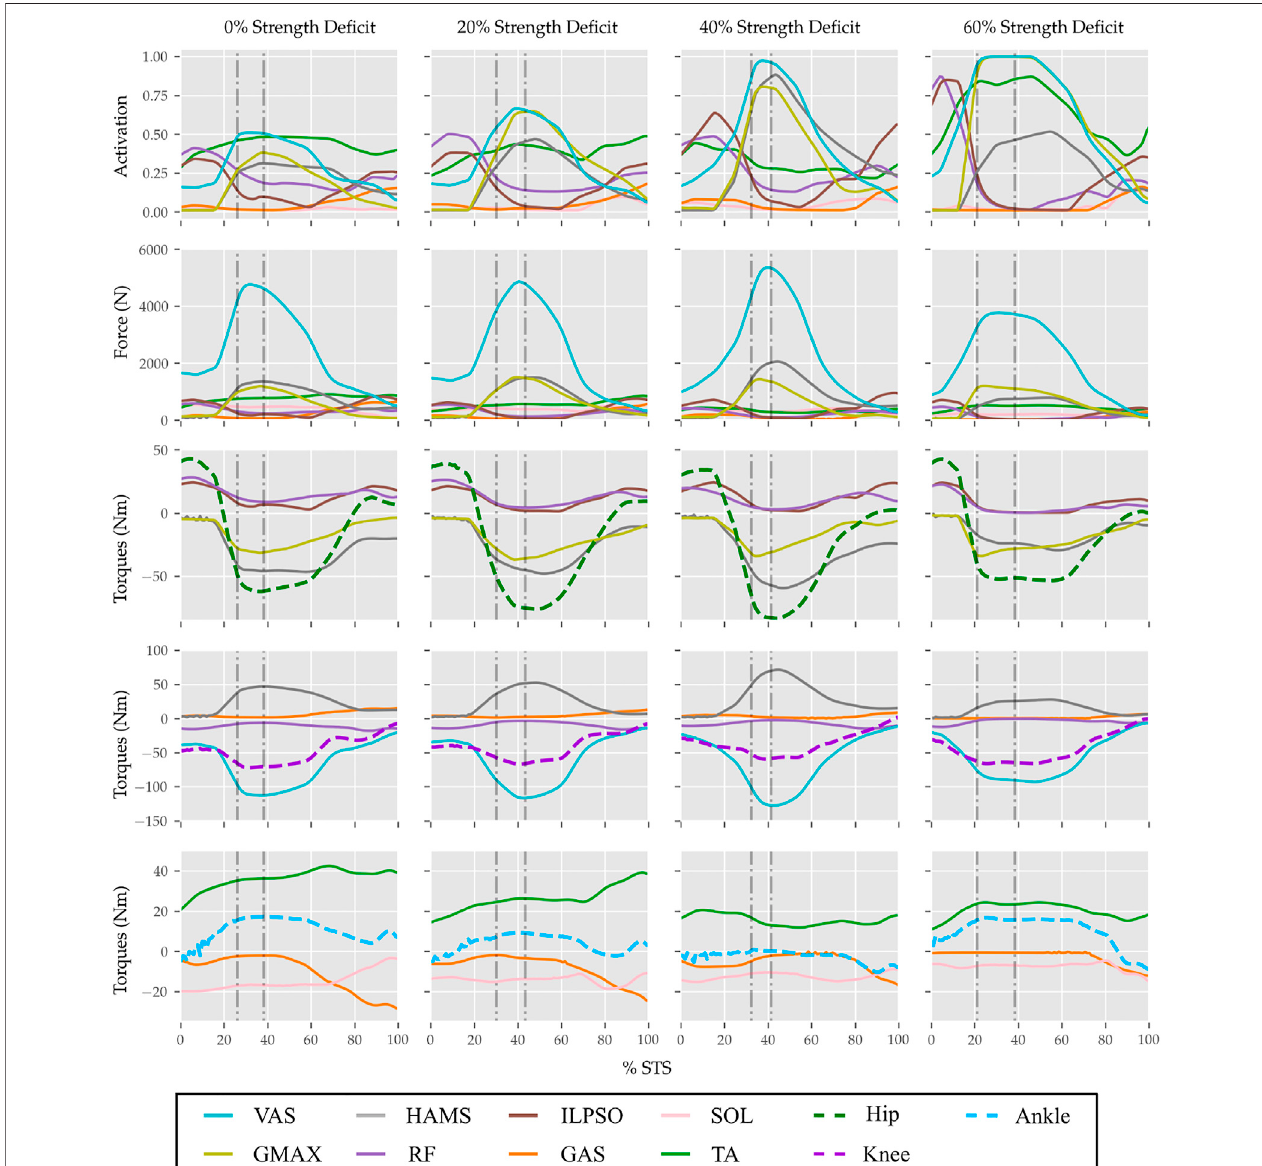
FIGURE 11 | Muscle activations, muscle forces, and their respective contributions to the resultant joint torques from the STS trajectories of 0, 20, 40 and 60% strength de fi cit models.